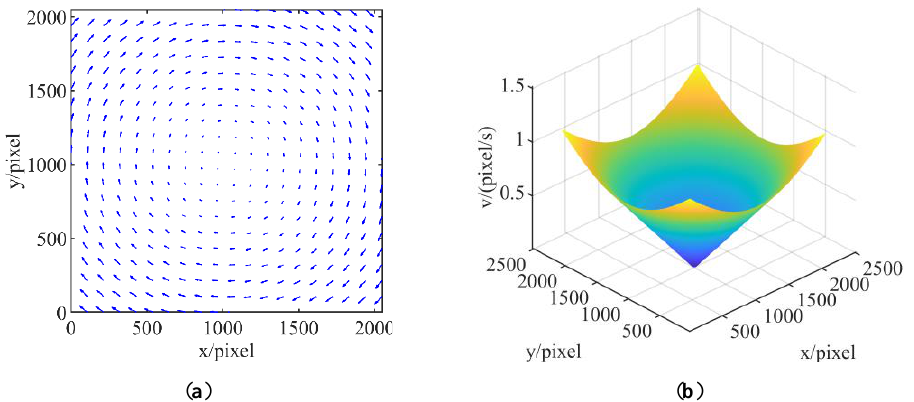
Figure 7. Velocity magnitude and direction distribution. ( a ) Velocity vector direction distribution diagram. ( b ) Velocity vector magnitude distribution diagram.